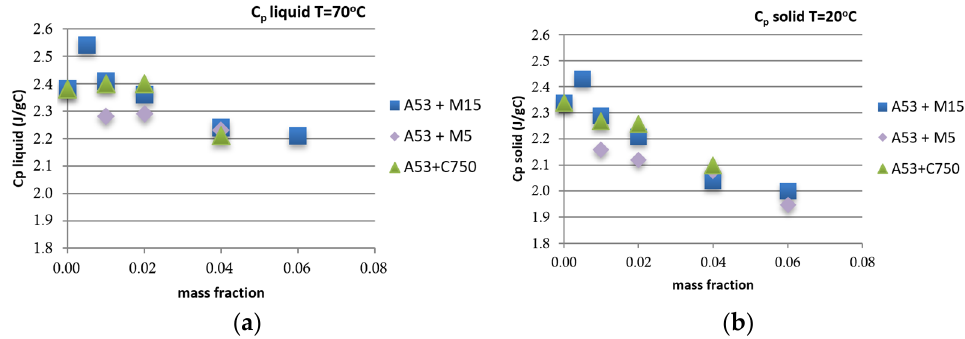
Figure 5. Heat of fusion as a function of mass fraction of: squares, M15 (diameter = 15 μ m, thickness = 6–8 nm, and surface area = 120–150 m 2 /g); rhombuses, Μ 5 (diameter = 5 μ m, thickness = 6–8 nm, and surface area = 120–150 m 2 /g), and triangles, C750 (diameter < 2 μ m, thickness = a few nm, and surface area = 750 m 2 /g).